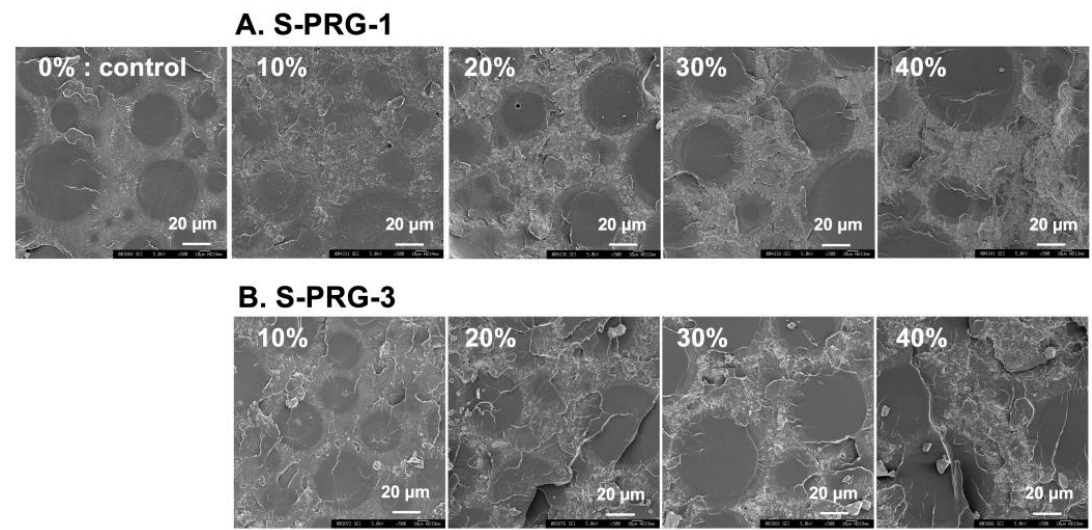
Figure 4. Representative SEM images at the fracture surfaces of the specimens after the three-point bending test. ( A ) S-PRG-1 and ( B ) S-PRG-3 at ×500 magnification.